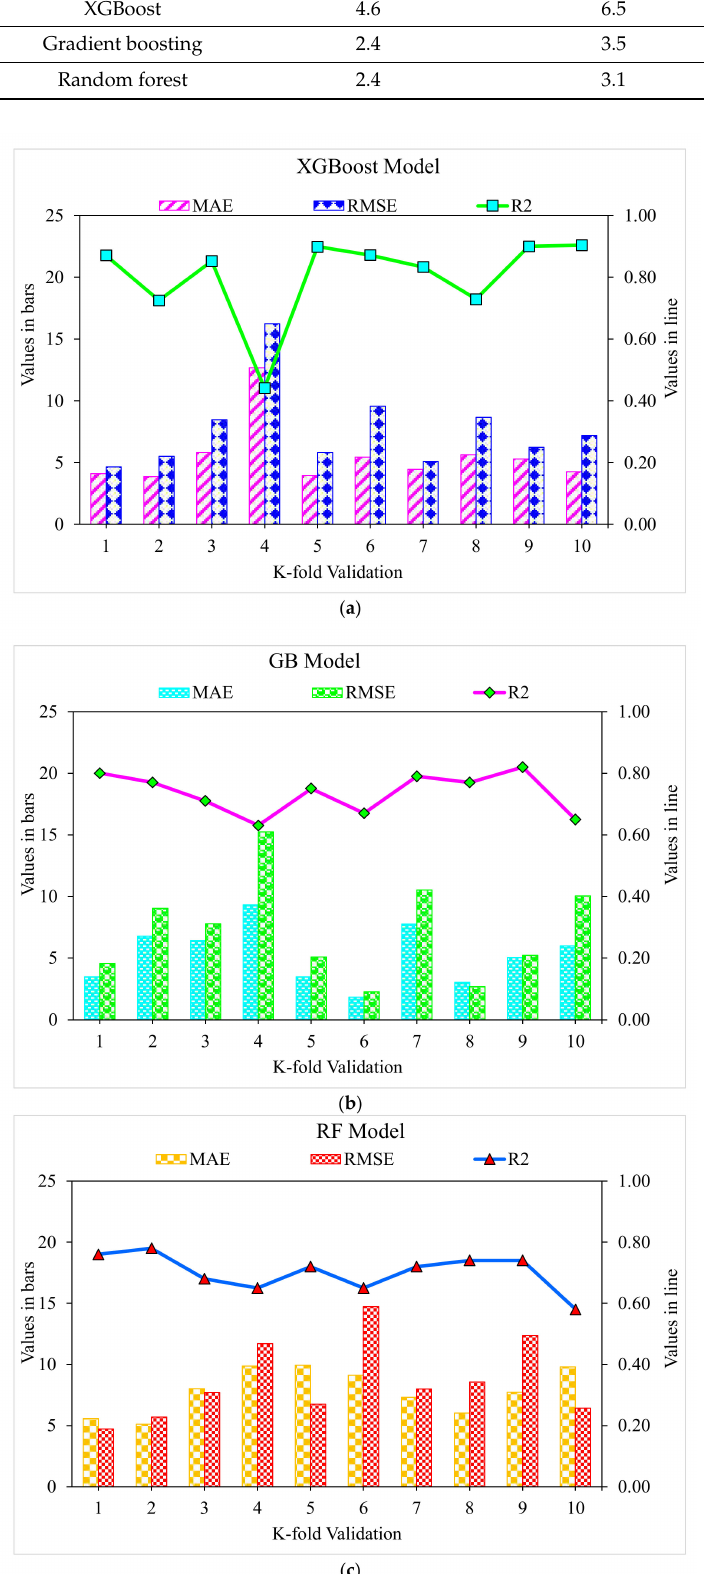
Figure 14. Statistical representation: ( a ) XGBoost; ( b ) gradient boosting; and ( c ) random